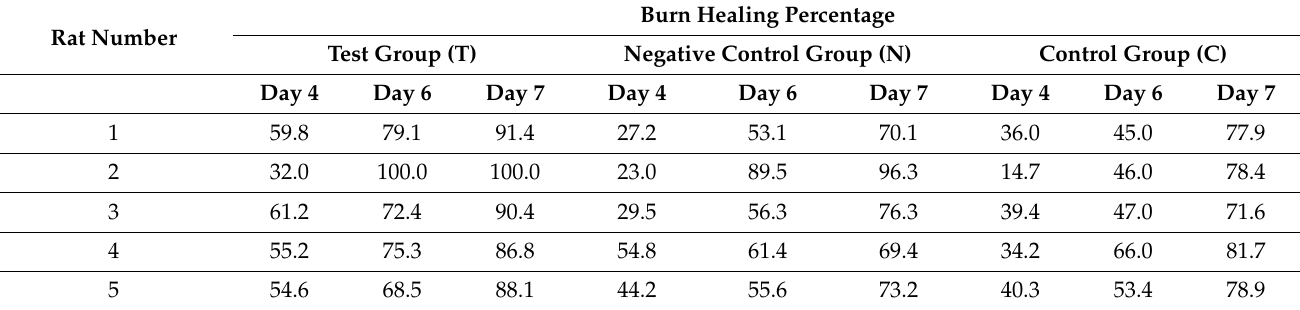
Table 2. Percentage of burn area contraction.